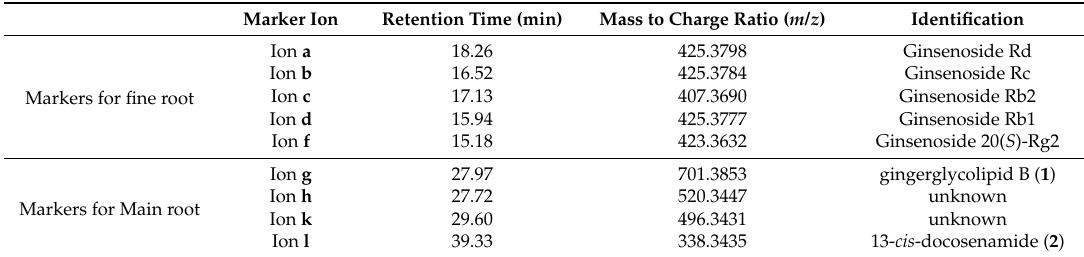
Table 1. Selected potential markers.